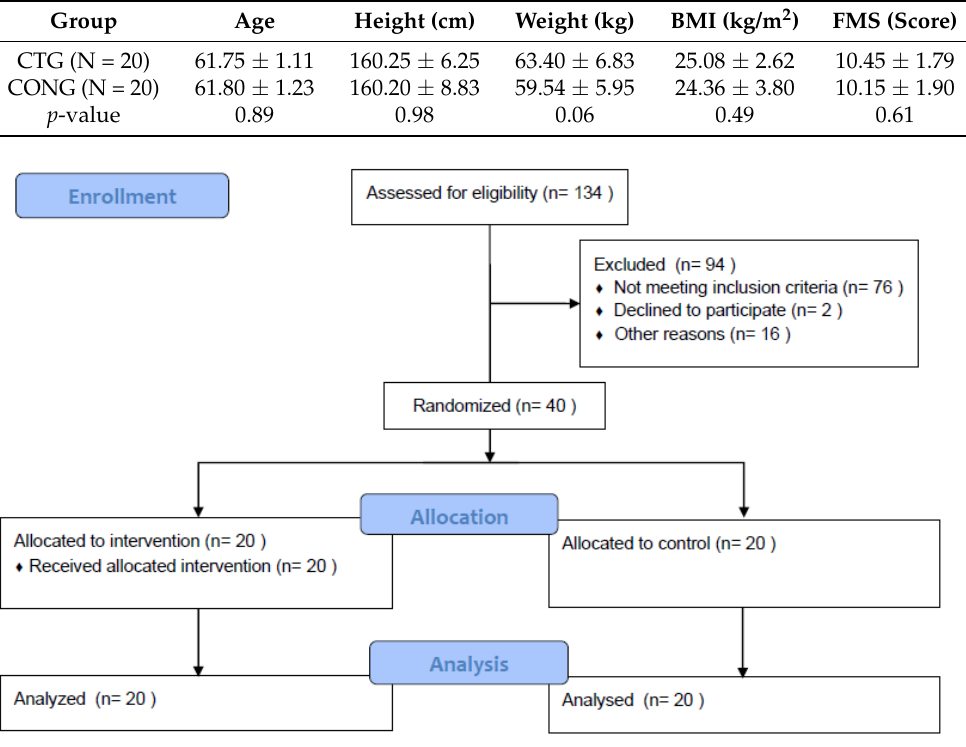
Figure 1. Study flowchart.